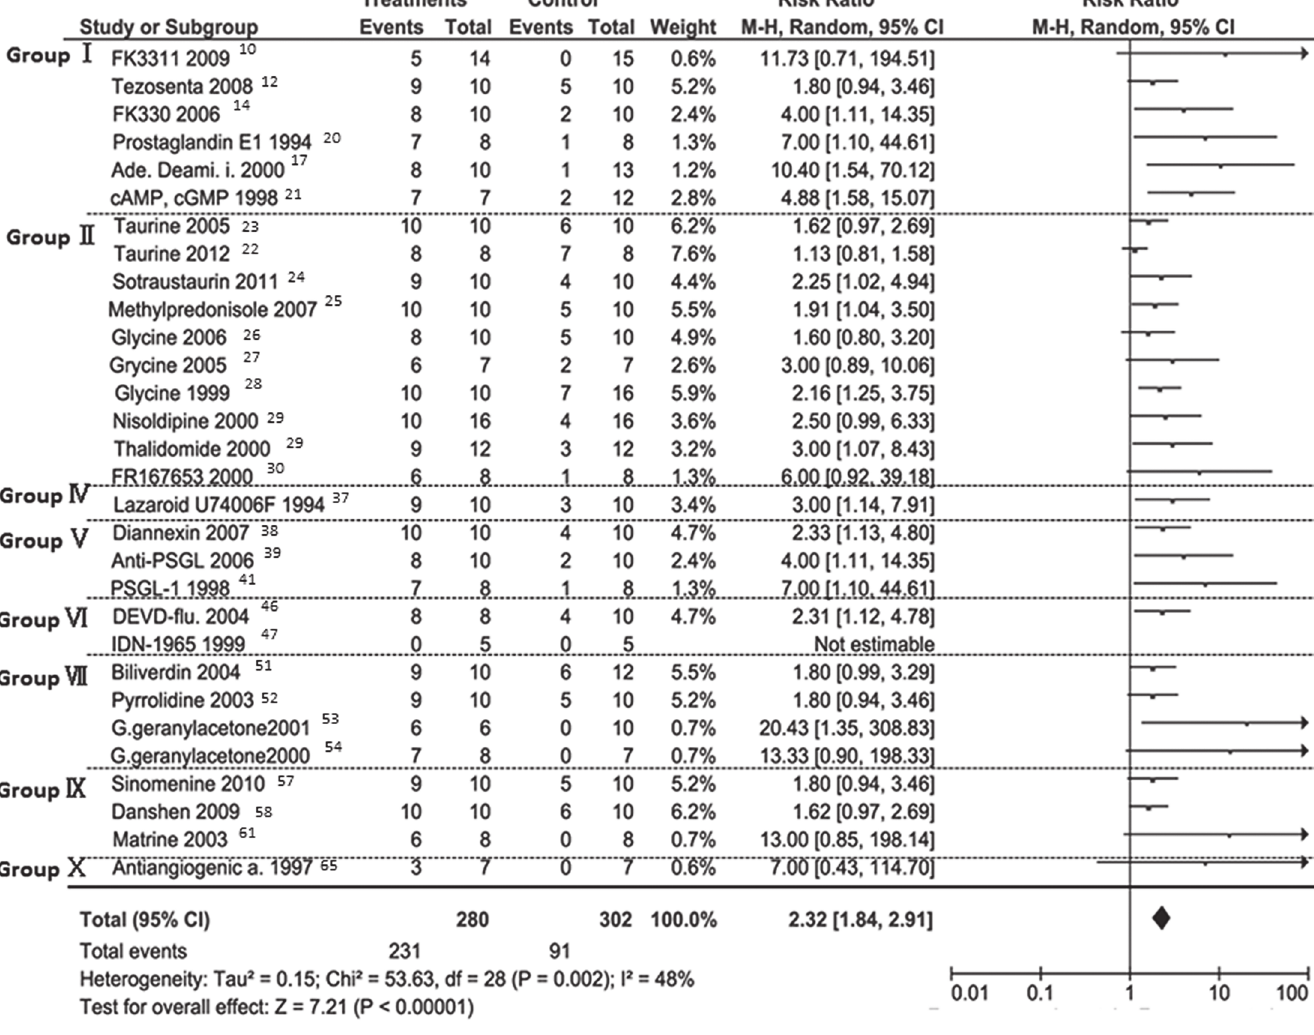
Fig 3. Annotated forest plot for meta-analysis of risk ratio of seven-day-survival